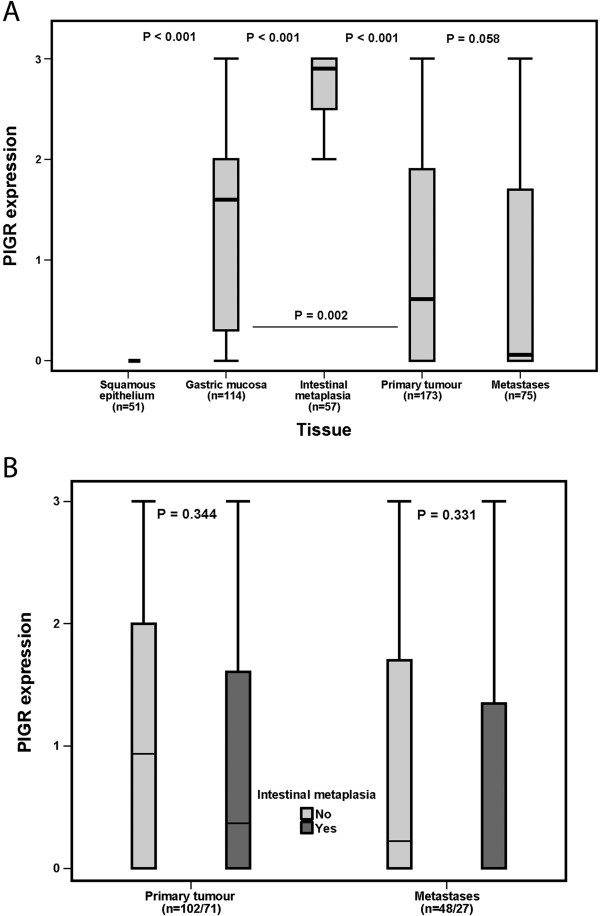
PIGR expression in normal tissues, intestinal metaplasia, primary tumours and metastases. (A) Box plots visualizing the distribution of PIGR expression (total score) in normal squamous epithelium, intestinal metaplasia (Barrett’s esophagus or gastric intestinal metaplasia), primary tumours and metastases in the entire cohort, and (B) primary tumours and metastases in cases with and without reported Barrett’s esophagus/intestinal metaplasia, respectively.